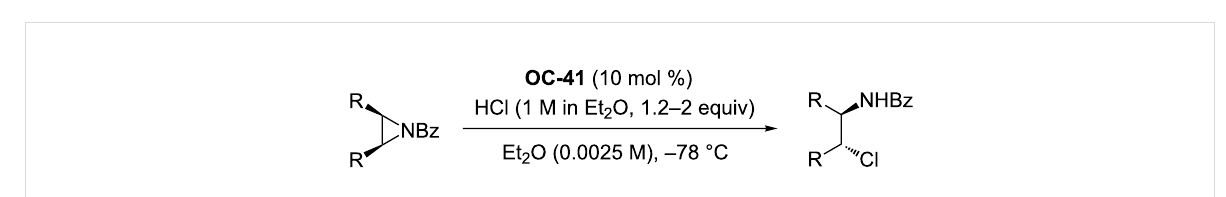
Figure 8: The chiral thioureas OC-28 to OC-44 for the desymmetrization of meso -aziridines.